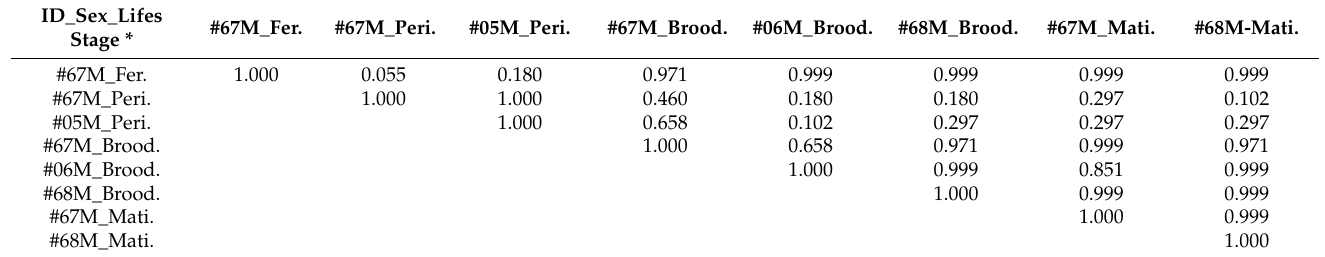
Table 3. Kolmogorov–Smirnov p -values in examining differences between TPMs of different observations.